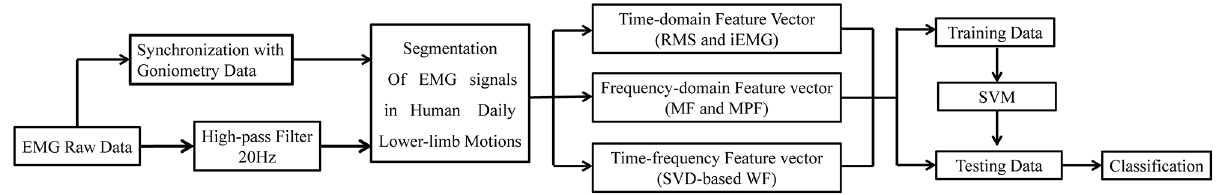
Fig 1. The evaluation procedure for classification of four types of lower-limb